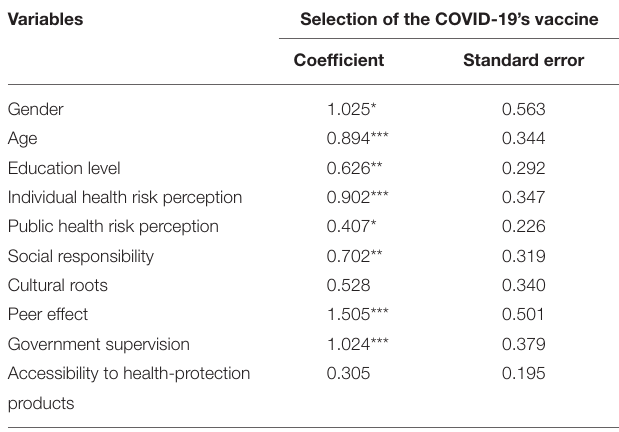
TABLE 2 | Estimation results of vaccination selection equation based on logit